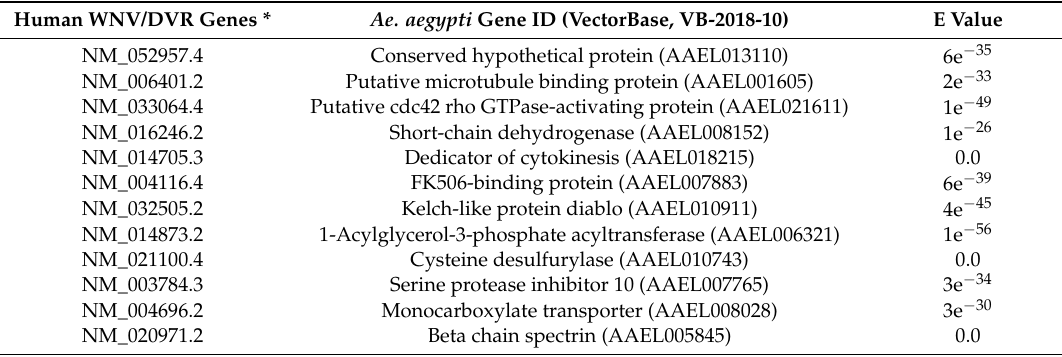
Table 1. Twelve Aedes aegypti homologs of human West Nile/dengue virus-resistance genes reported by Krishnan et al